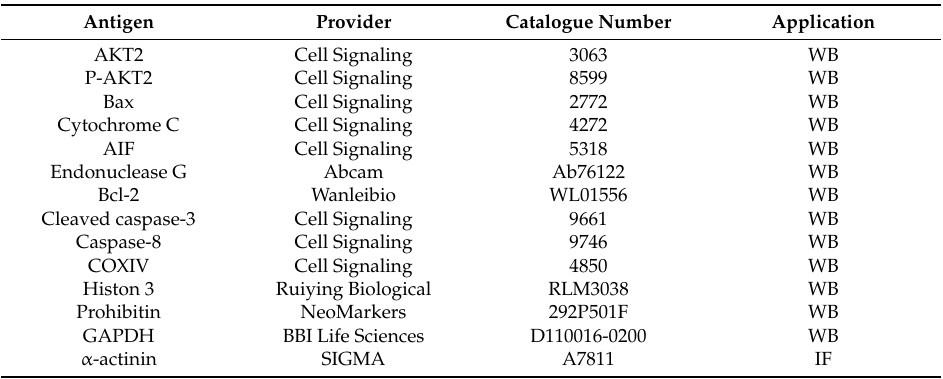
Table 2. Antibodies (Applications used were IF: Immunofluorescence, WB: Western